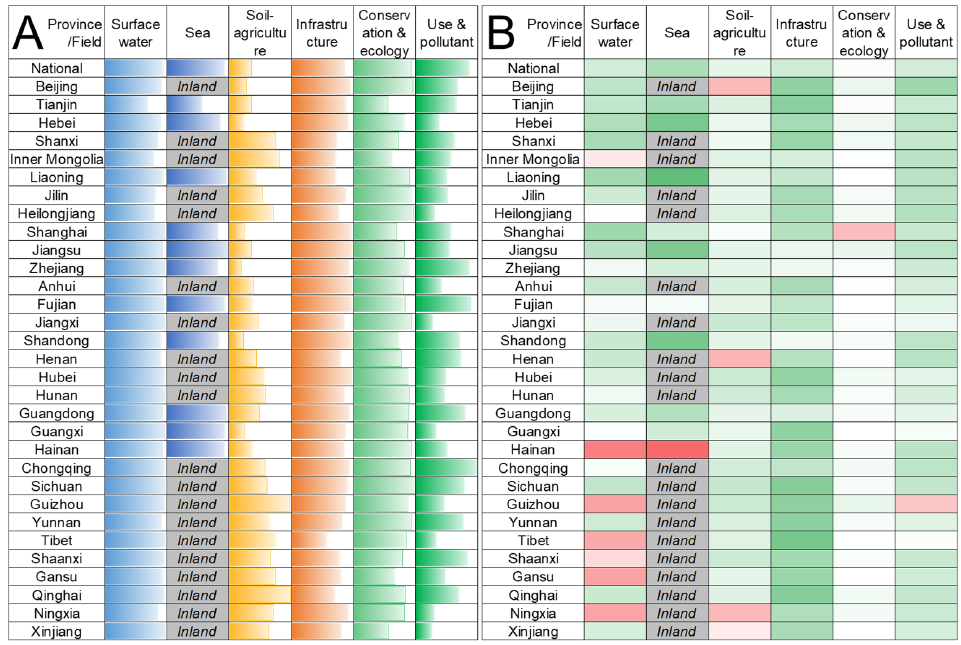
Figure 2. Provincial water sustainability evaluation (A) and development (B) between 2015 and 2021.